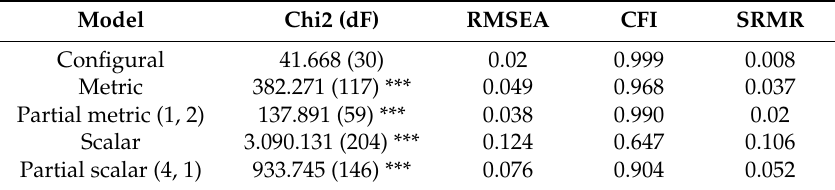
Table A3. Multigroup confirmatory facto analysis—global fit measures for the measurement equivalence of the 4-items model, full sample.